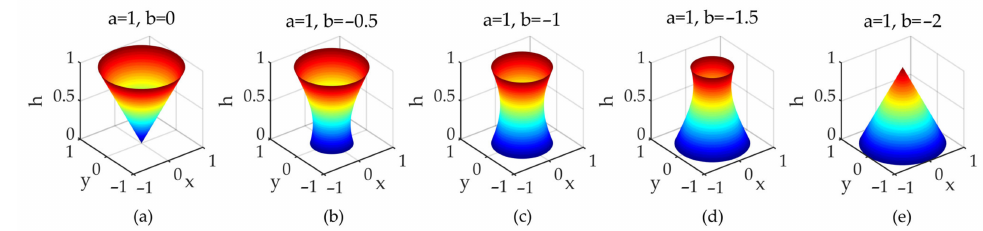
Figure 16. Rendering graphs of five transition crown shapes from the inverted cone to the cone. The parabola factors are ( a ) a = 1, b = 0; ( b ) a = 1, b = − 0.5; ( c ) a = 1, b = − 1; ( d ) a = 1, b = − 1.5; and ( e ) a = 1, b = −